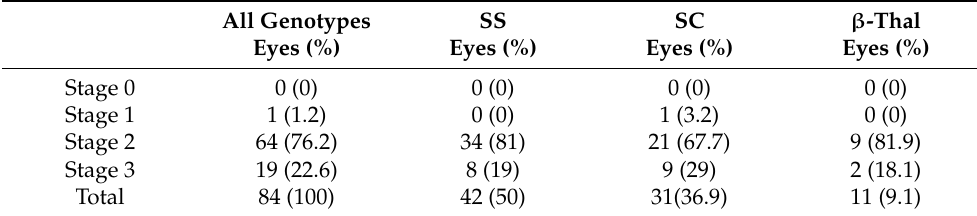
Table 1. Goldberg staging based on UWF-FA and stratified by genotype.